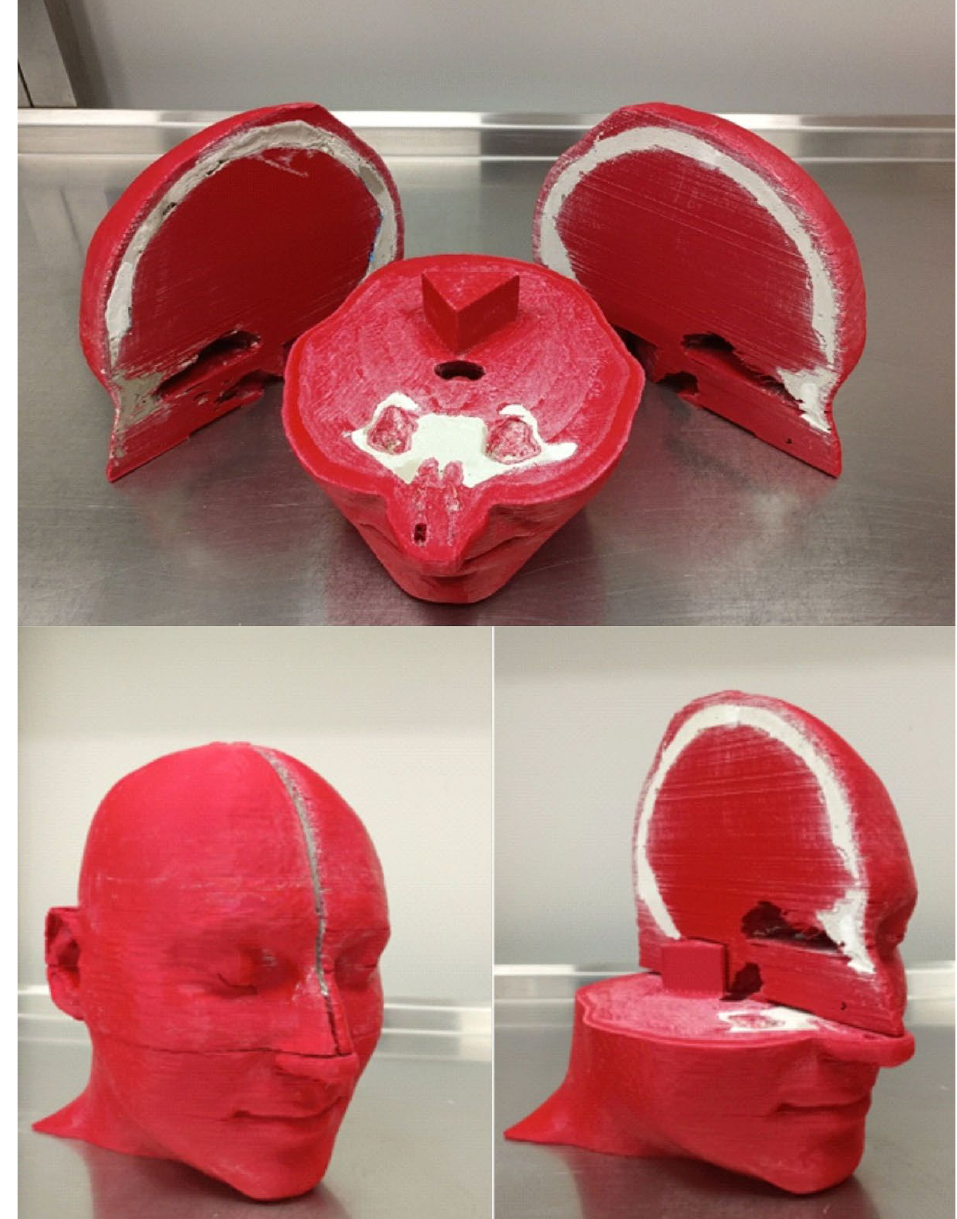
Figure 2. Finished 3D printed anthropomorphic head phantom used for purpose of this study. A custom-printed personalized surface applicator was used to perform the phantom simulated treatment. The design of the custom applicator was based on CT images of the head phantom taken with 1 mm layers separation. The resulting images were imported into the OncentraBrachy TM treatment planning system. The first step was to determine the outer contour of the phantom, using the lung window (width of 1,600 HU with center at -600 HU). Using such settings allows to prepare an applicator that fits well on the facial surface. Using the transverse CT images, 10 sample target areas (CTV 1-10) were deline- ated on the facial surface, which were located at different linear and angular distances from the right eye. A bolus of 1 cm was then added to the outer contour of the patient at eye level. The added volume covers the area where the target volumes were located. The prepared bolus on the surface of the phantom outline is shown in Figure 3. At the height